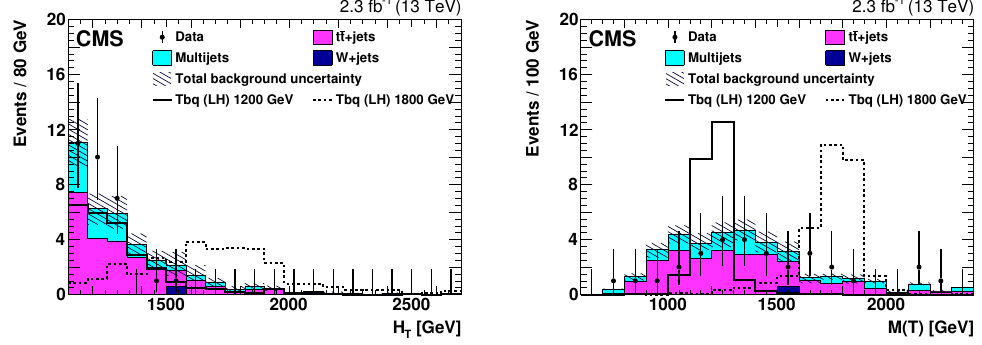
Figure 3 . The H T (left) and M (T) (right) distributions after full event selection. The black markers with error bars are the data. The various background components are shown as (cid:12)lled histograms, and are estimated using simulations (tt+jets and W+jets) and the data (non-tt+jets and non-W+jets multijets component). The simulated T quark signal distributions for two T quark masses are also shown. The values of the product of the signal cross sections and the branching fraction B (T ! tH) are taken to be 1